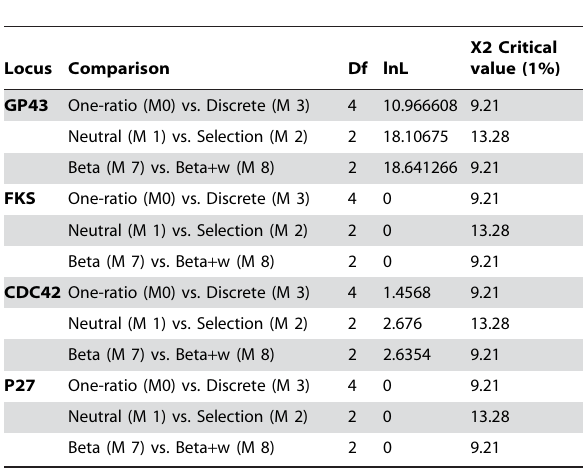
Table 5. Likelihood ratio statistics of different